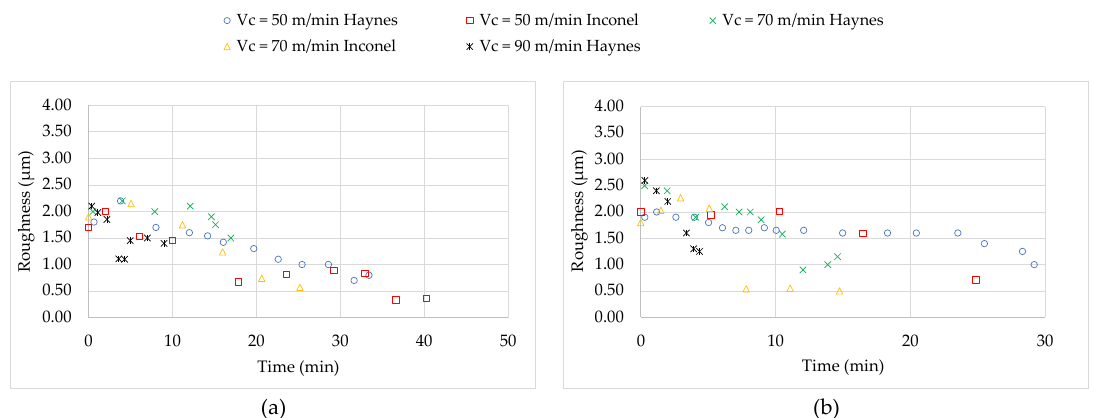
Figure 11. Machined surface roughness for Haynes [36] and Inconel [38] under conventional cooling pressure: ( a ) feed = 0.1 mm/rev, ( b ) feed = 0.15 mm/rev.